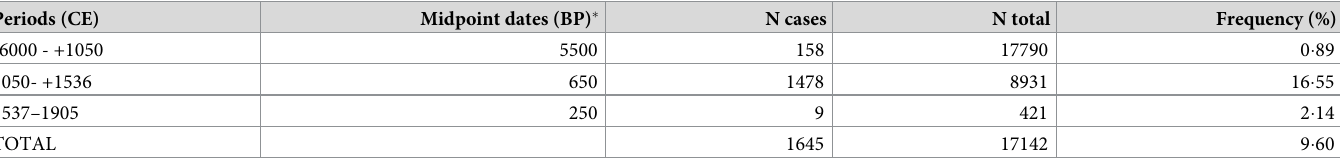
Table 3. Frequency of bone signs of leprosy in consecutive periods of human